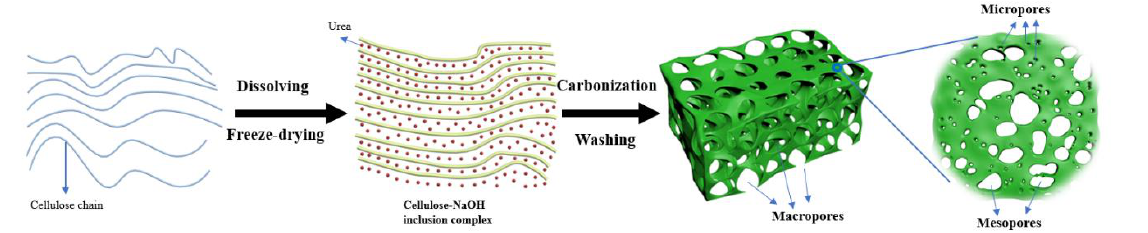
Scheme 1. Preparation of cellulose aerogel derived hierarchical porous